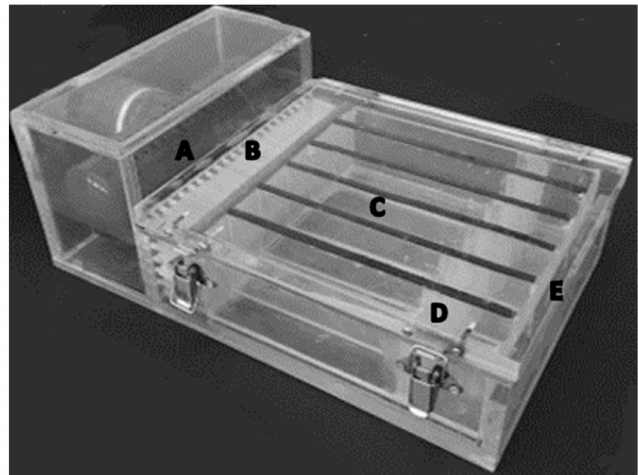
Figure 1. Swimming chamber used in the critical swimming speed and swimming endurance experiments carried out with white seabream Diplodus sargus (Linnaeus, 1758) larvae. The design of this swimming chamber was based on Stobutzki and Bellwood [14,21] and later modified by Faria et al. [44]. Water flows into the swimming chamber through a perforated PVC pipe (A), which then passes through two sets of plastic flow di ff users ( ∅ - 5 mm; 40 mm in length) to uniformize incoming water flow (B) and prior flowing into the six parallel swimming lanes (180 × 30 × 50 mm; L × W × H) (C). Two mesh bands are installed on the extremities of each lane to avoid larvae from entering into the di ff users (B) and from being washed out from the chamber (D) at the water exit extremity (E). Larvae were randomly selected from the holding tank and transferred to a swimming lane.